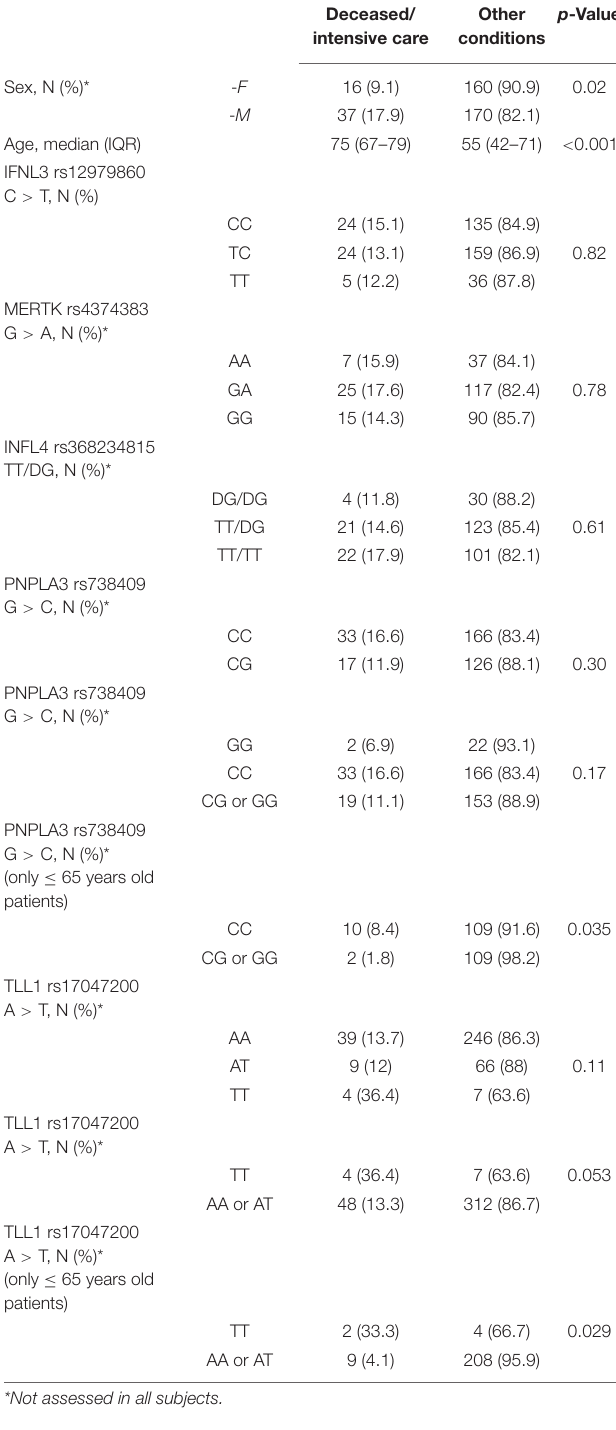
TABLE 4 | Risk factors associated with severe outcome (death or intensive/critical care N % Expected frequency in the Caucasian General population (%)